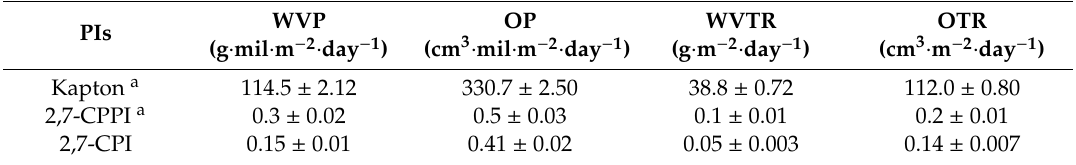
Table 2. Barrier properties of Kapton, 2,7-CPPI and 2,7-CPI